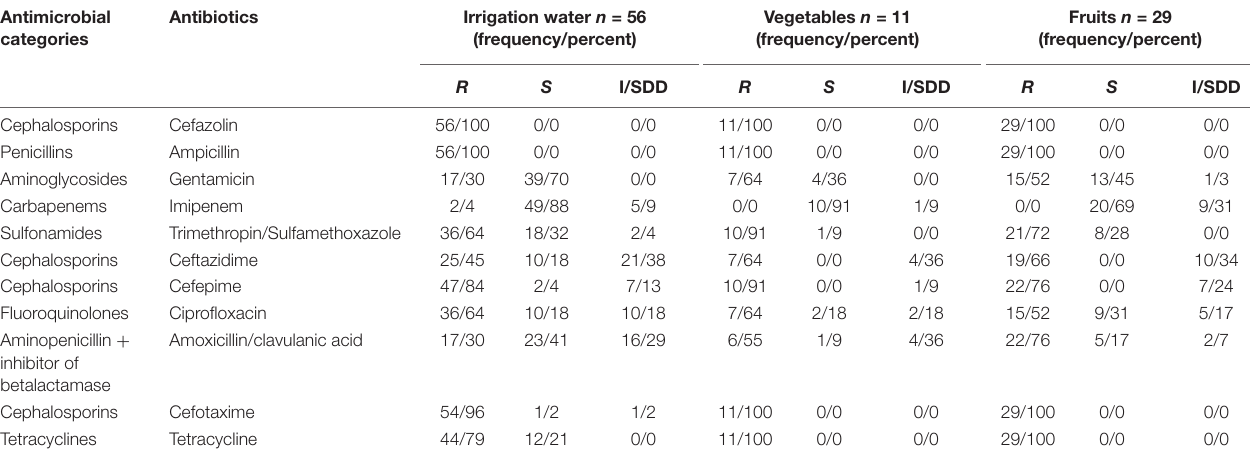
TABLE 2 | Antibiotic susceptibility profiles of isolates ESBL- E.coli from irrigation water, vegetables, and fruits. Antimicrobial Antibiotics Irrigation water n = 56 categories